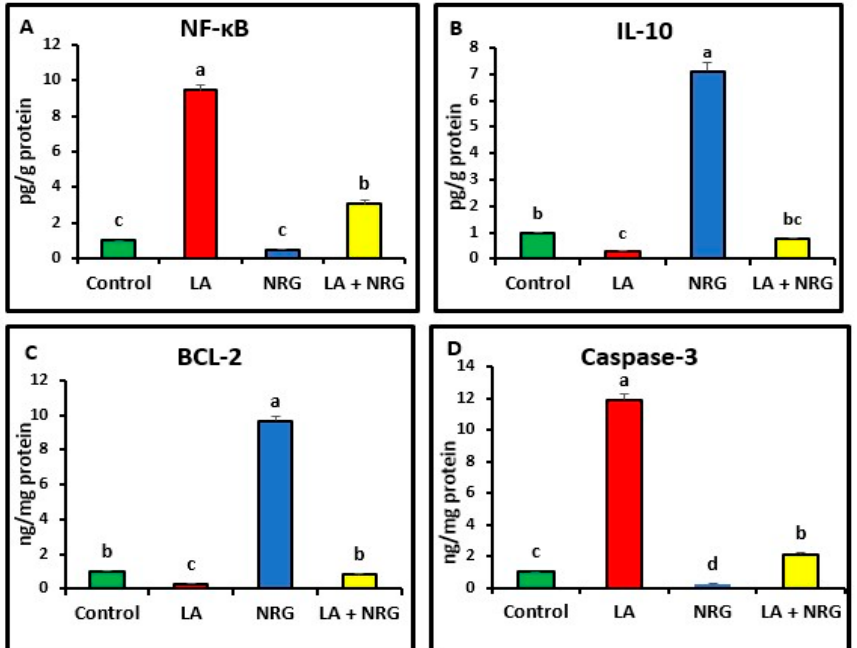
Figure 6. Hepatic pro- and anti-in fl ammatory mediators: ( A ) NF- κ B (Pg/g protein), ( B ) IL-10 (Pg/g protein), ( C ) BCL-2 mRNA expression (ng/mg protein), and ( D ) caspase-3 mRNA expression (ng/mg protein) in the di ff erent experimental groups at the 4th week of treatment of LA-intoxicated rats with NRG (mean ± SE). The means in each chart with di ff erent superscripts are signi fi cantly di ff erent ( p < 0.05). NF- κβ : nuclear factor kappa-B; IL-10: interleukin 10; BCL-2: B-cell lymphoma 2; caspase-3: cysteine-aspartic proteases. a for the high value; b, c for intermediate values between a and d, while d for the lower value.